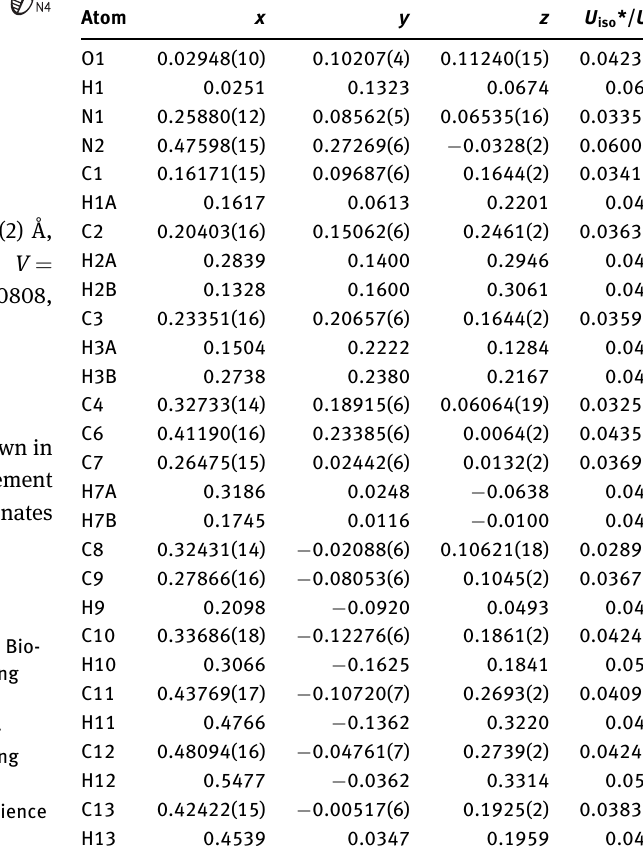
Table 2: Fractional atomic coordinates and isotropic or equivalent isotropic displacement parameters (Å 2